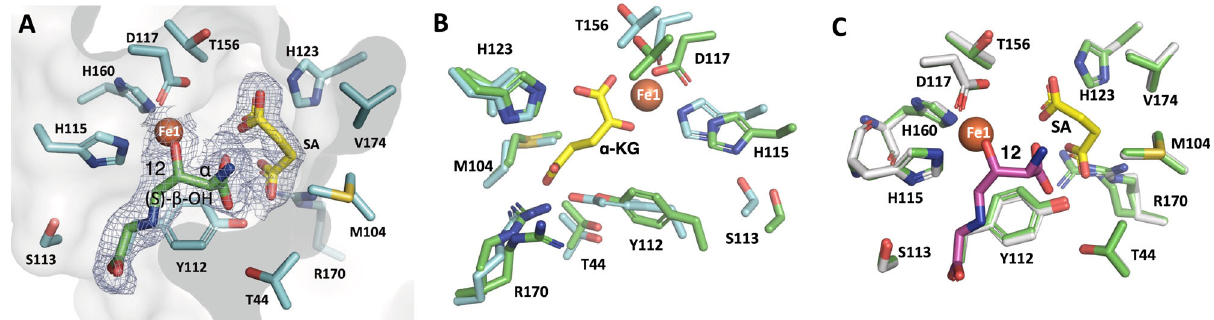
Fig. 6 Crystal structure of Cpz10 in complex with Fe1 and α -KG and 2-amino-3-hydroxybutanoic acid. A Closed-up view of the Cpz10 active site, where the active site Fe1 (colored orange) is coordinated with H106, H154, D108, succinic acid (SA) and 2-amino-3-hydroxybutanoic acid moiety of compound 12 (colored green). α KG has undergone decarboxylation to form SA (colored yellow); compound 11 that replaces water (W91; Fig. 4B) at the sixth coordinate has been converted to compound 12 , where the newly introduced OH group poses an S -con fi guration at β C in agreement with expected product. B Closed- up active-site view of Cpz10 apo (colored green) superimposed over that in complex with α -KG (colored yellow) with a r.m.s.d of 0.54, indicating Cpz10 undergoing some degree of conformational change. C Closed-up active-site view of Cpz10 apo (colored green) superimposed over that in complex with compound 12 (colored magenta) and SA (colored yellow) with a r.m.s.d of 0.1, indicating Cpz10 undergoing less extent of conformational change after formation of compound 12 and SA. 2F o -F c electron-density maps are contoured at 1 σ (Supplementary Fig. 11 for stereo